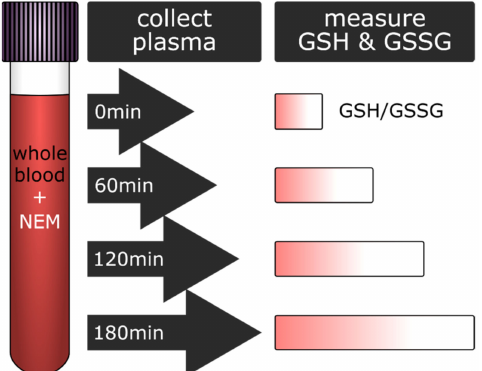
Figure 4. Summary of the workflow and the obtained results. Blood from 20 healthy volunteers was collected in pre-NEMylated blood collection tubes (2.5 mM final NEM concentration). At regular intervals (0, 60, 120, and 180 min), an aliquot of collected blood from each volunteer was spun down to collect the plasma, which was then used for further analysis and revealed an increase in GSH concentration in a time-dependent